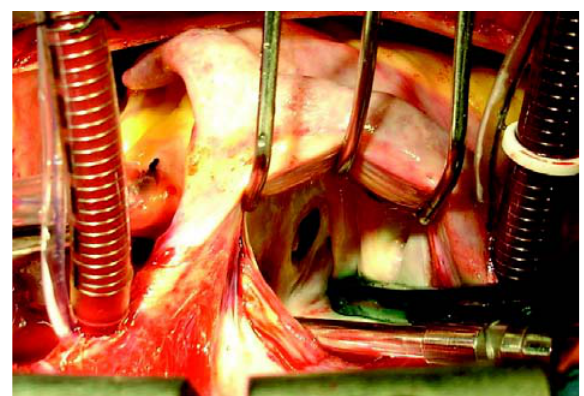
Fig. 1 - Átrio esquerdo aberto evidenciando a presença de membrana com orifício ovalado de cerca de 1,5 cm, dividindo-o em duas câmaras comunicantes